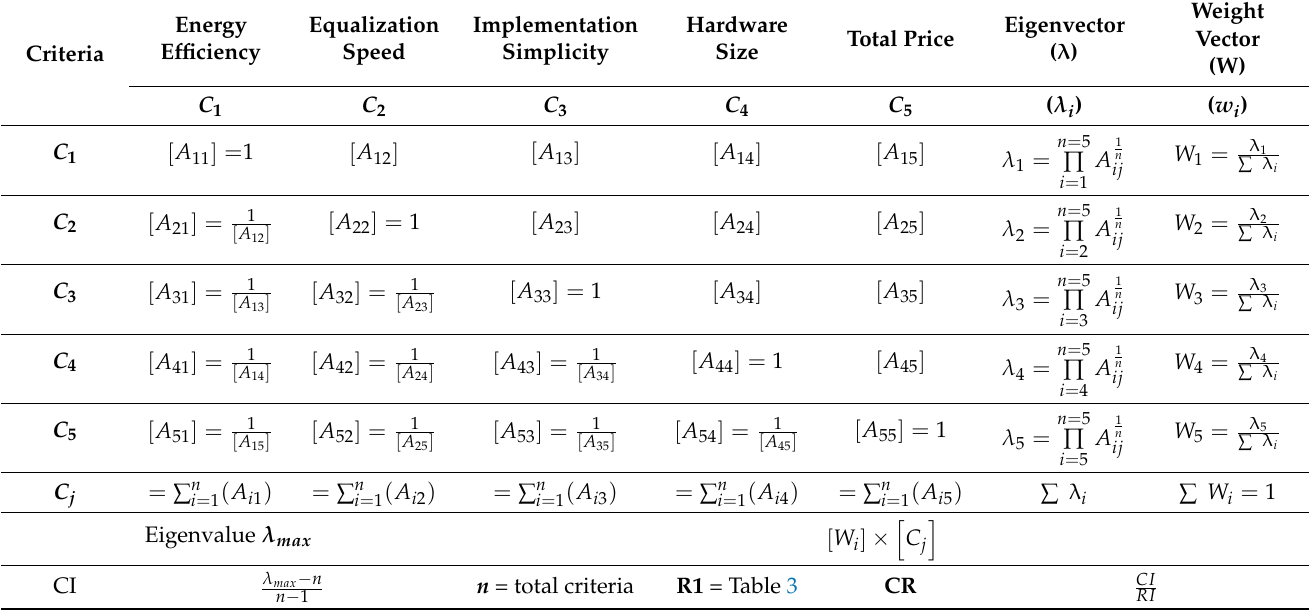
Table 2. Calculations to obtain pairwise comparison matrix A